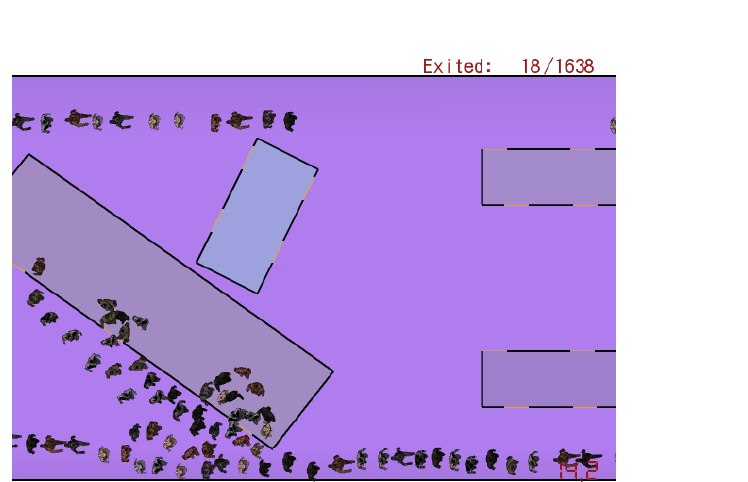
Figure 3 – Modeled occupants in the tunnel simulation model after 14.2 seconds from the start of the simulation Рис . 3 – Смоделированные пассажиры в симуляционной модели тоннеля спустя 14,2 секунды от начала симуляции Slika 3 – Modelovani ljudi u simulacionom modelu tunela posle 14,2 sekunde od po č etka